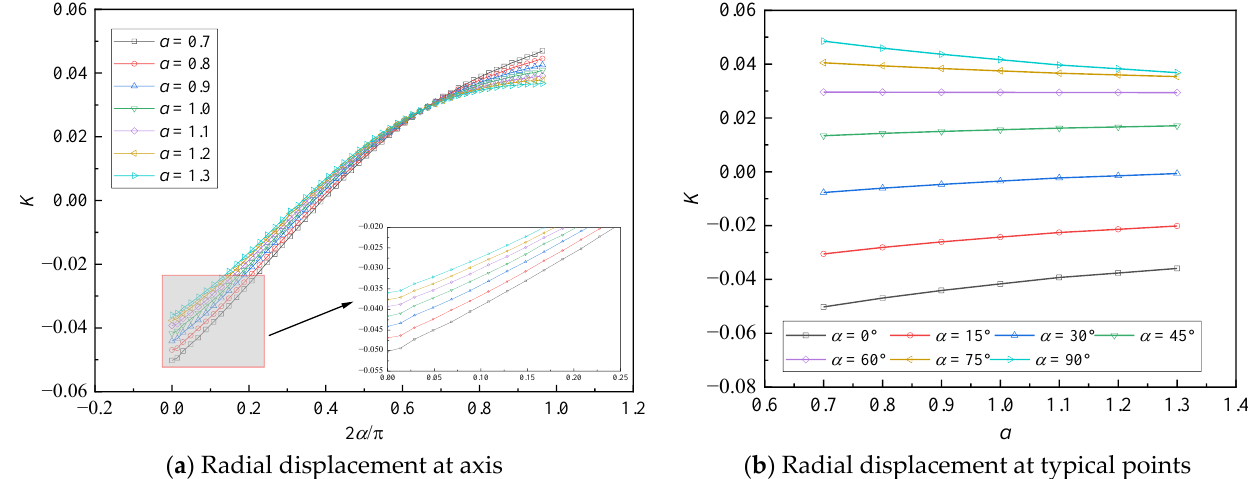
Figure 4. Radial displacement in the single factor test of parameter a.